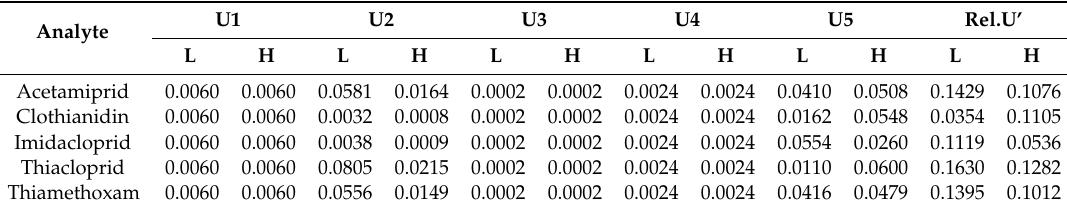
U1—uncertainty of standard solutions. U2—uncertainty of calibration curves. U3—uncertainty of weighing. U4—uncertainty of pipetting and dilution operations. U5—uncertainty of precision. Rel. U (cid:48) —relative expanded